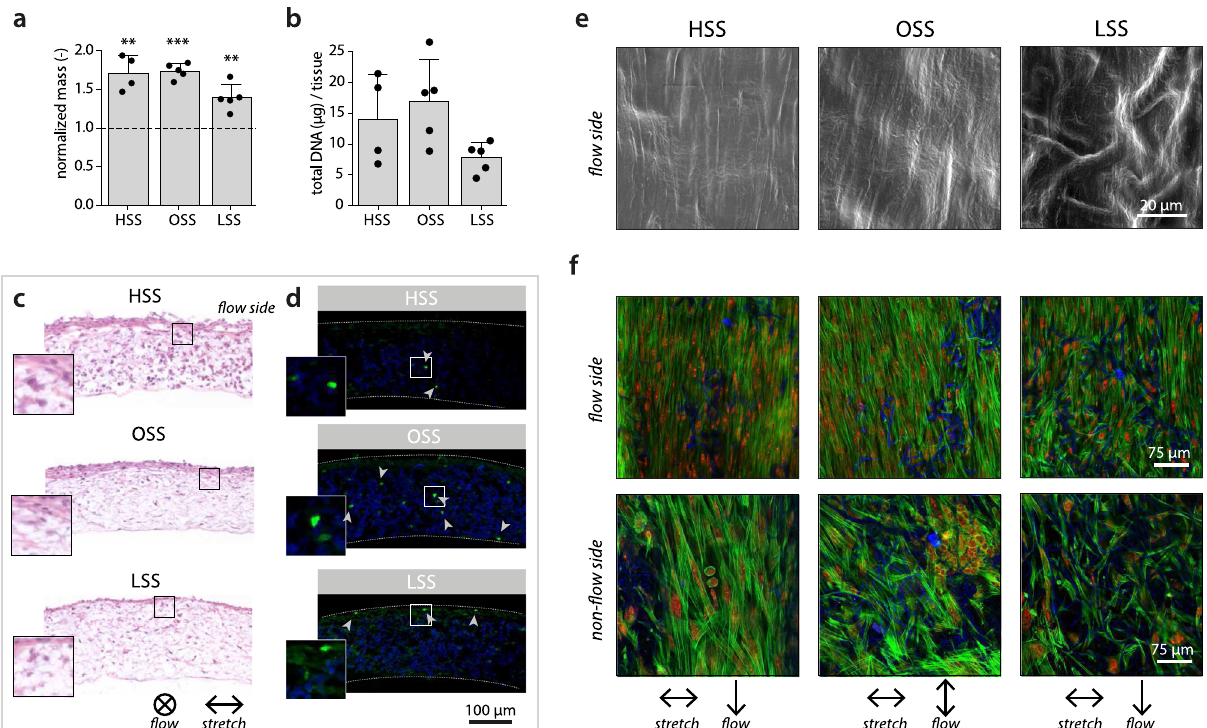
Fig. 4 Cell and tissue growth at day 14 under different types of shear stress. a Overall construct mass/surface at day 14 normalized to scaffold mass/ surface prior to seeding (dashed line indicates no change, ** p < 0.01, *** p < 0.0001 tested with a one sample t -test). b Total DNA content per tissue construct. c Hematoxylin and eosin-stained cross-sections. d Localization of Ki67-positive cells (Ki67 in green, scaffold material in blue, dashed lines indicate construct borders). e Scanning electron microscope image of the cell and tissue morphology. f In-plane visualization of the F-actin cytoskeleton (actin in green, nuclei in red, and scaffold fi bers in blue). Bars represent mean ± standard deviation. HSS high shear stress condition (3.2 Pa, n = 4), OSS oscillatory shear stress condition (±3.2 Pa, n = 5), LSS low shear stress condition (0.4 Pa, n =